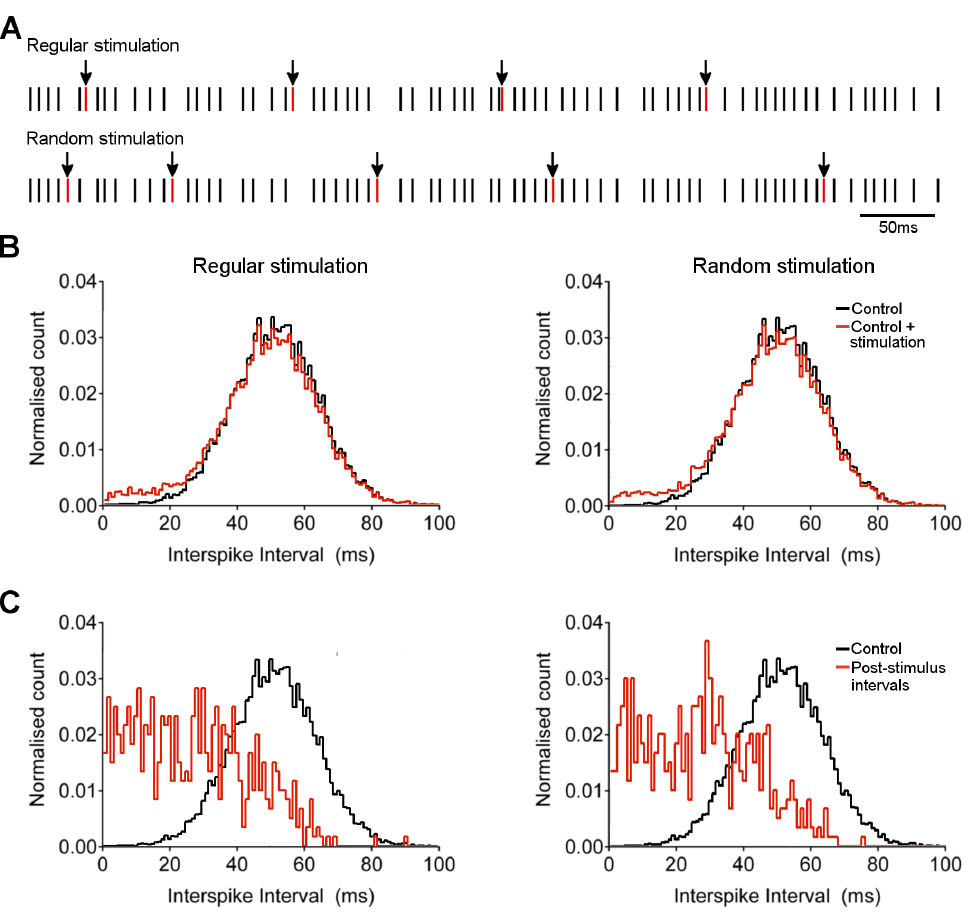
Figure 1. Addition of single spikes to a spike train. A) A spike train (black lines) was generated by sampling from a Gaussian distribution of interspike intervals (mean=50 ms, SD=12.5 ms), to which additional single spikes were added to simulate a stimulus event (red lines, arrows) at a regular frequency of 1 Hz, or randomly with a mean of 1 Hz (see Methods for more details). No refractory period was incorporated. B) Normalised distributions of interspike intervals before (black line) and after (red line) addition of single spikes to the train, with regular (first panel) and random (second panel) stimulus times. C) Distribution of post-stimulus intervals (red line) overlaid on distribution in the absence of stimulation (black line). Note appearance of a population of shorter than average intervals due to bisection of existing